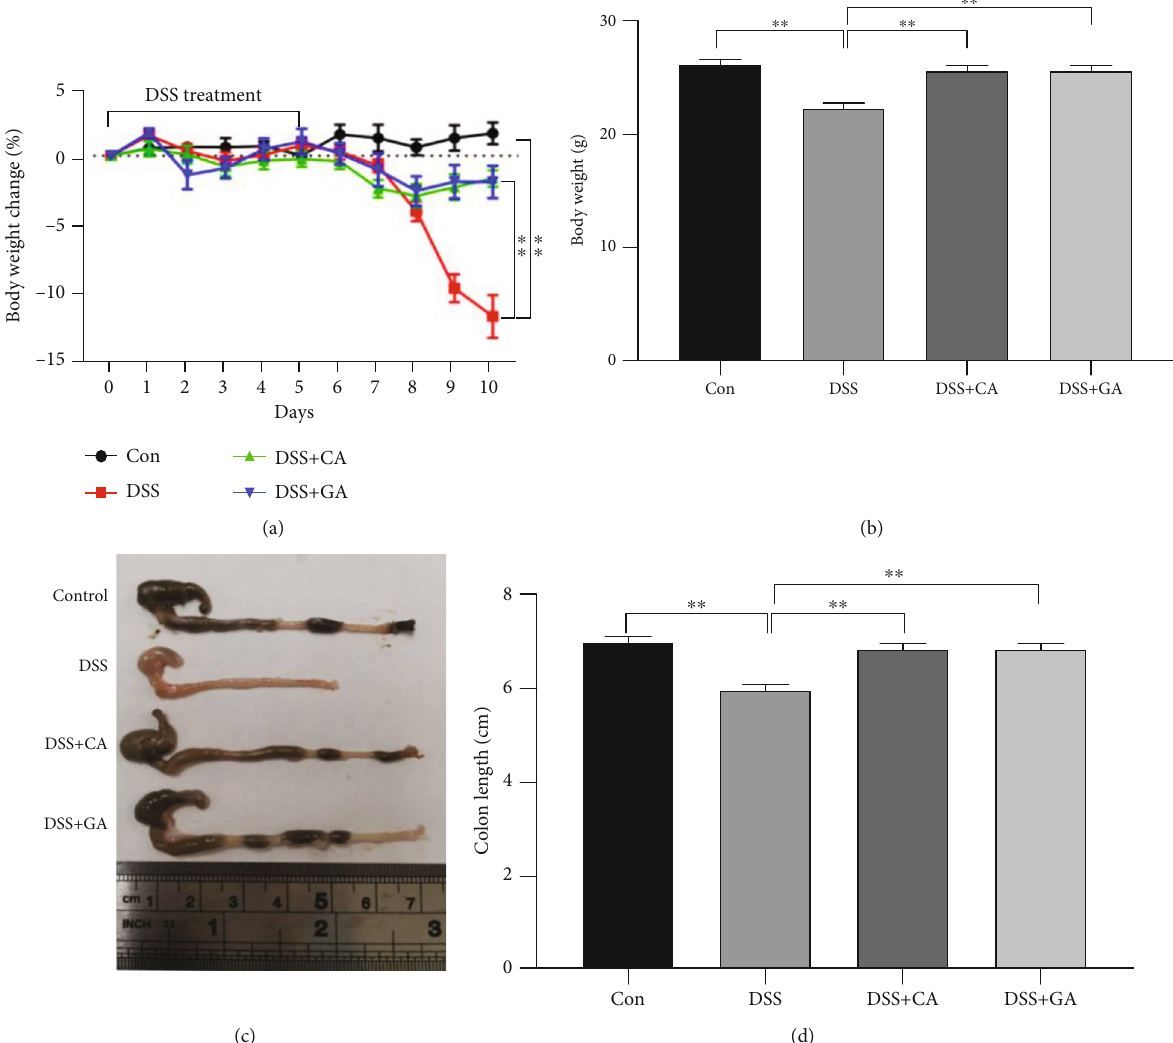
Figure 1: The e ff ect of cecropin A and antibiotic treatment in 2.5% DSS-treated mice on body weight (a and b) and colon length (c and d). The data were analyzed by one-way ANOVA ( n = 9 ) and are shown as the mean ± SEM with ∗ P < 0 : 05 , ∗∗ P < 0 : 01 , ∗∗∗ P < 0 : 001 versus